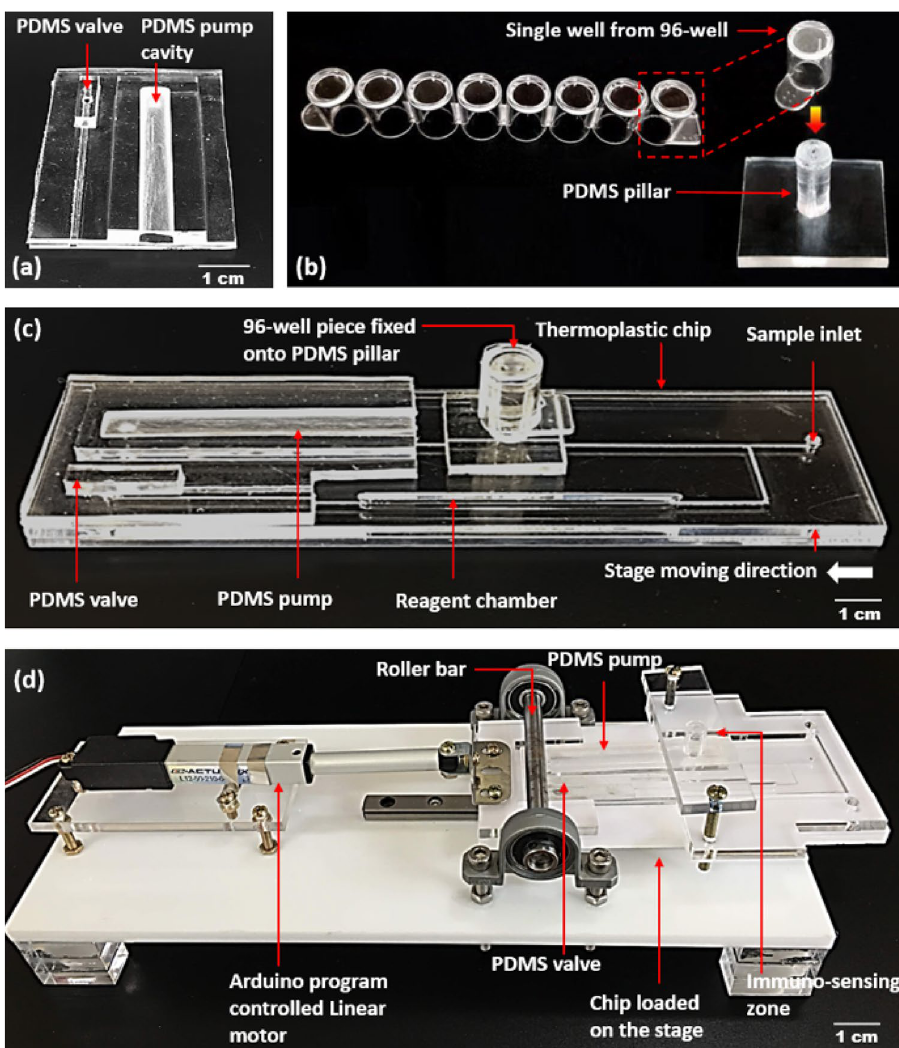
Figure 4. Details of the proposed device. The fabricated ( a ) PDMS actuator, ( b ) PDMS pillar to fix with a well separated from 96-well microplate. ( c ) The PDMS actuator and PDMS pillar attached to a thermoplastic LOC device with patterned micro-channels, and ( d ) the roller driving frame with a chip-loading stage is connected to a linear motor. The stage holding the thermoplastic chip moves laterally under a roller